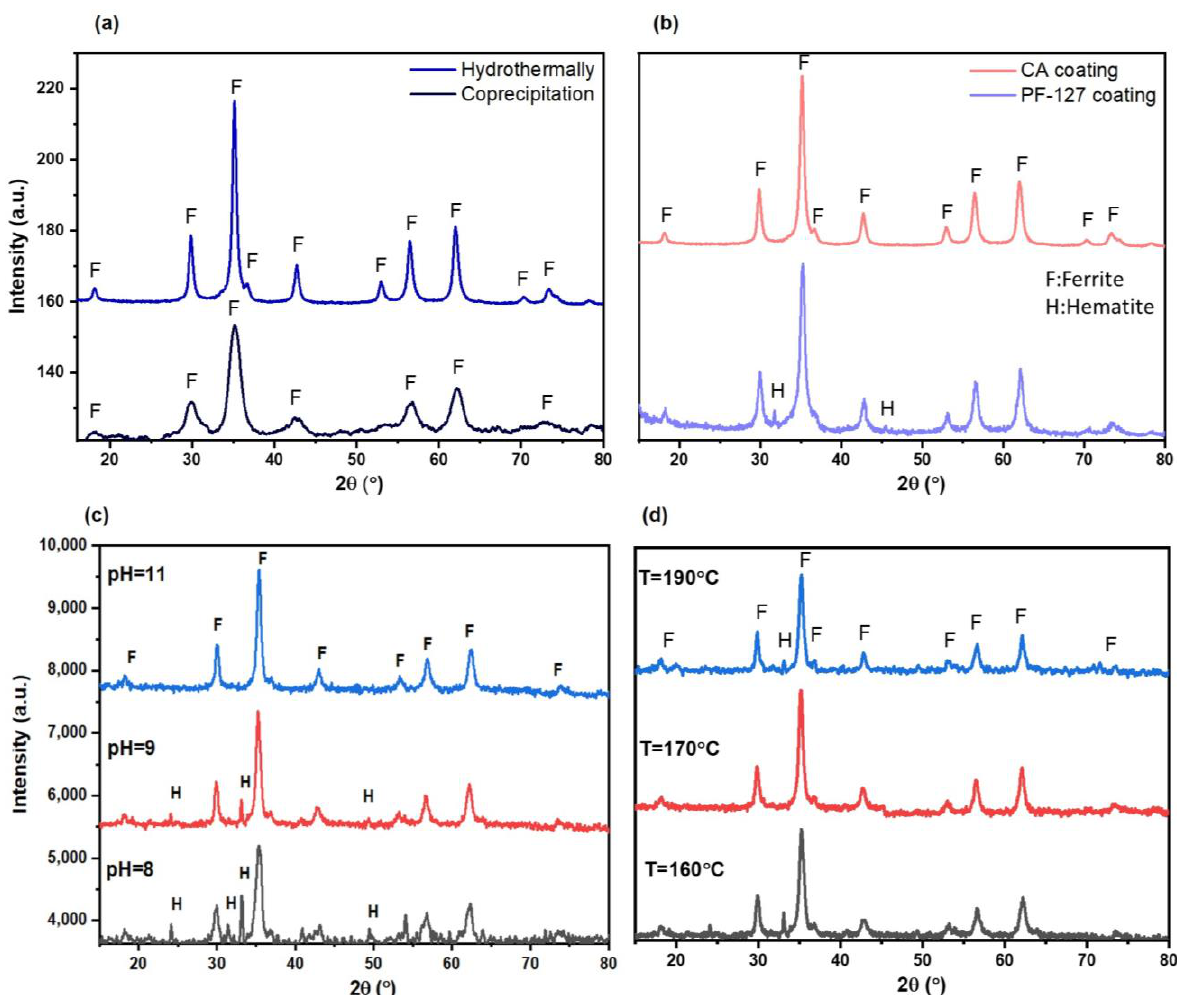
Figure 2. X-ray diffraction patterns of pure MZF nanoparticles synthesized ( a ) with co-precipitation and hydrothermal methods ( b ) with different coatings of citric acid (CA) and pluronic F-127 (PF-127) ( c ) at different precipitation pHs and ( d ) at different hydrothermal temperatures. Table 1. Crystallite sizes, lattice constants, saturation magnetizations ( M s ) and Curie temperatures (T c ) of the EuMZF nanoparticles with citric acid coating and with different values of